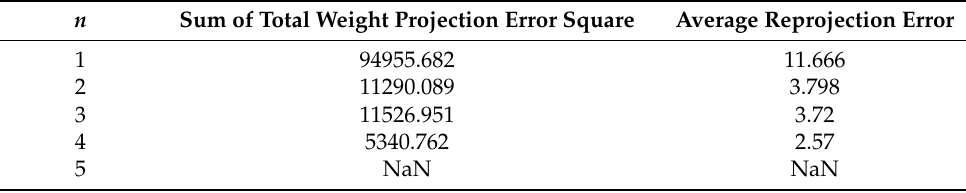
Table 2. Overall reprojection error table of all images to be marked when n = 1, 2, 3, 4, and 5.